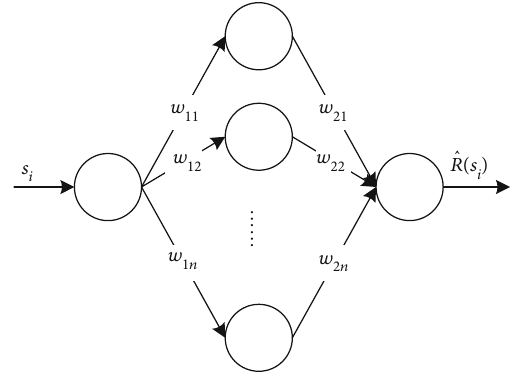
Figure 8: The BP neural network structure used for reliability